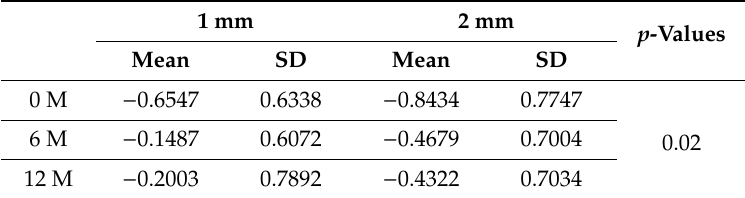
Table 7. Bone Position / Abutment Height.